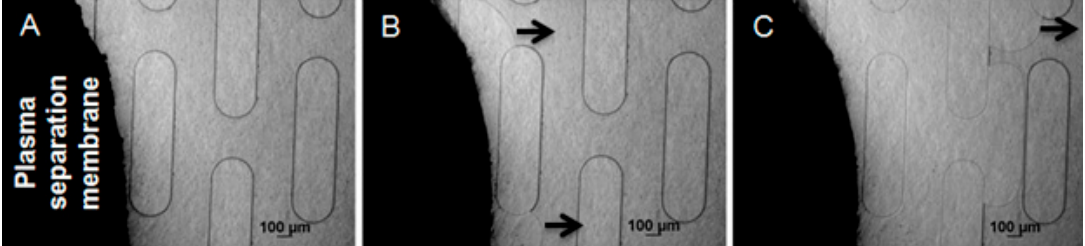
Figure 6. Plasma separation from whole blood. ( A ) Ready to separate; ( B ) Start to separate; ( C ) Continuous separation. The black arrows indicate the direction of the flow.